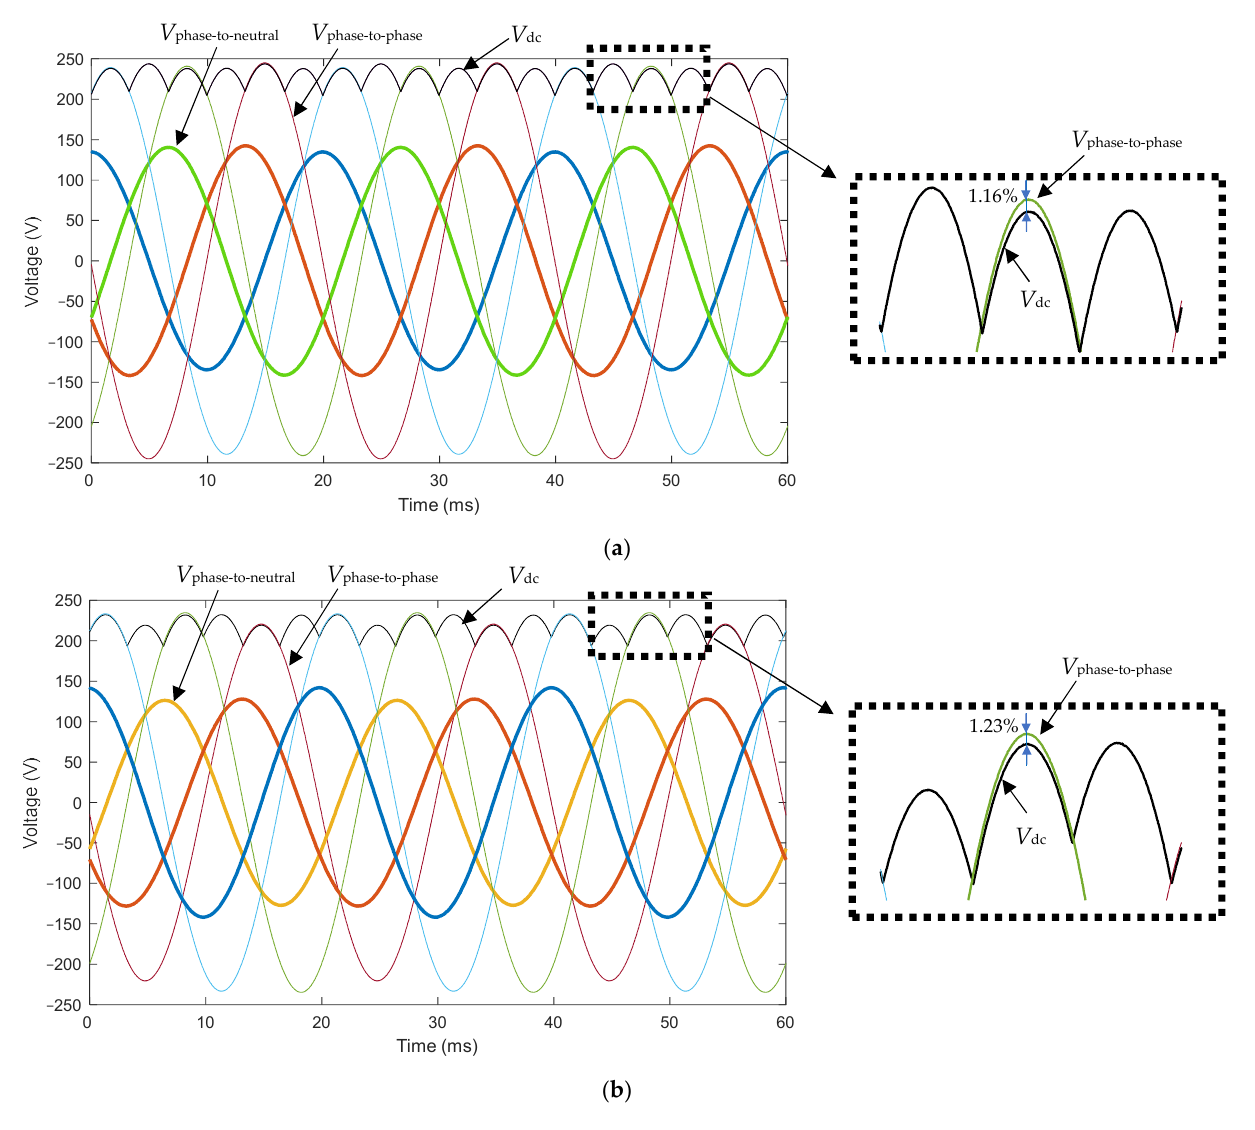
Figure 7. Experimental results. ( a ) Case 1: one-phase voltage drop of 5% (phase a) with respect to its rated value ( h = 0.95); ( b ) two-phase voltage drop of 10% (phases b and c) with respect to its rated value ( h = 0.9). Legend: solid thick line (blue, red, orange) = measured phase-to-neutral voltages; solid thin line (blue, red, green) = measured phase-to-phase voltages; solid black line = measured DC voltage.